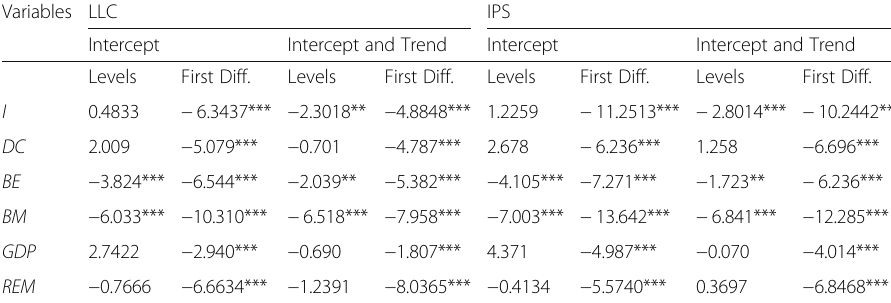
Table 4 Unit root tests results